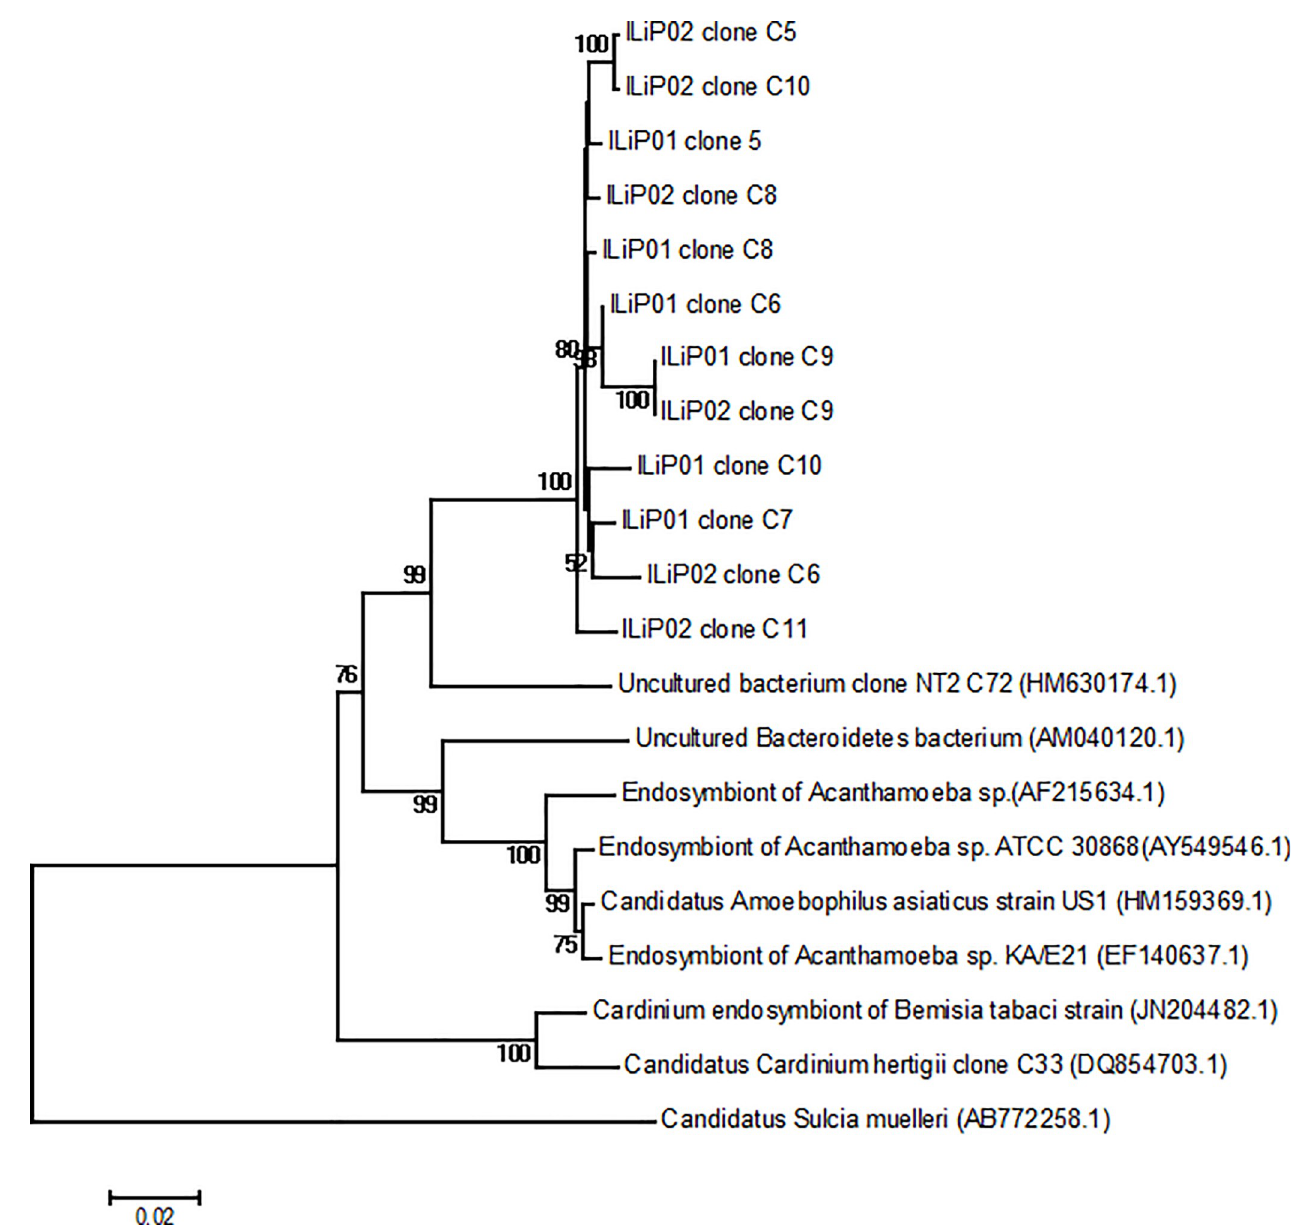
Fig 6. Neighbour-joining tree based on 16S rRNA gene sequences showing the relationship between cloned sequences from infected females, representatives of the genus ‘ Candidatus Cardinium hertigii’, endosymbiont of Acanthamoeba sp and related genera of the family Amoebophilaceae. The sequences were aligned using the Clustal W algorithm. Bootstrap values ( > 50%), based on 1000 replications, are given at the branching nodes. GenBank accession numbers are shown in parentheses. Candidatus Sulcia muelleri (AB772258.1) was used as an outgroup. Bar represents 0.01 substitutions per nucleotide